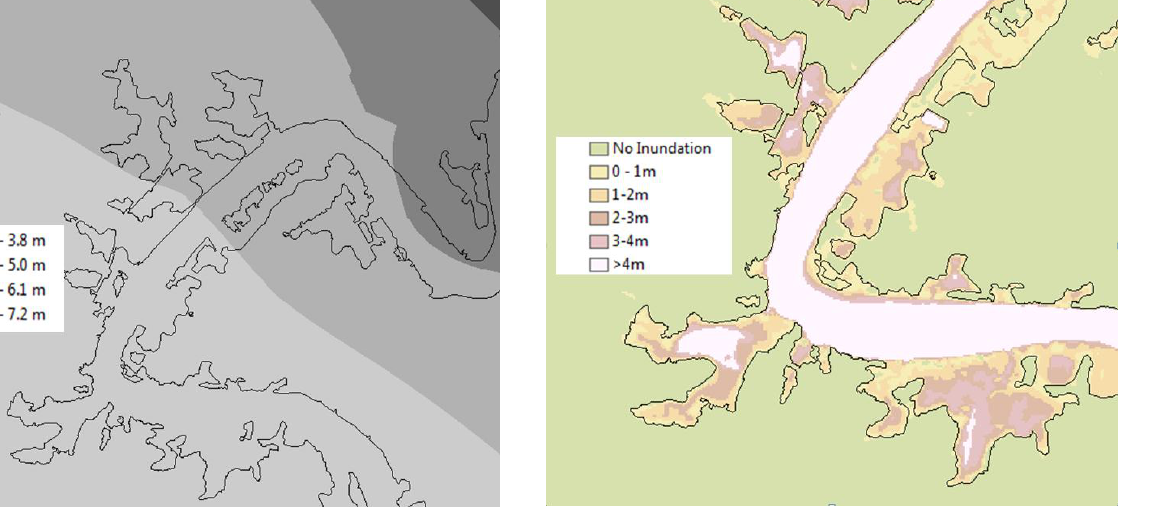
Figure 6. Flood surface generated from the surveyed points with the digitised flood lines overlaid.